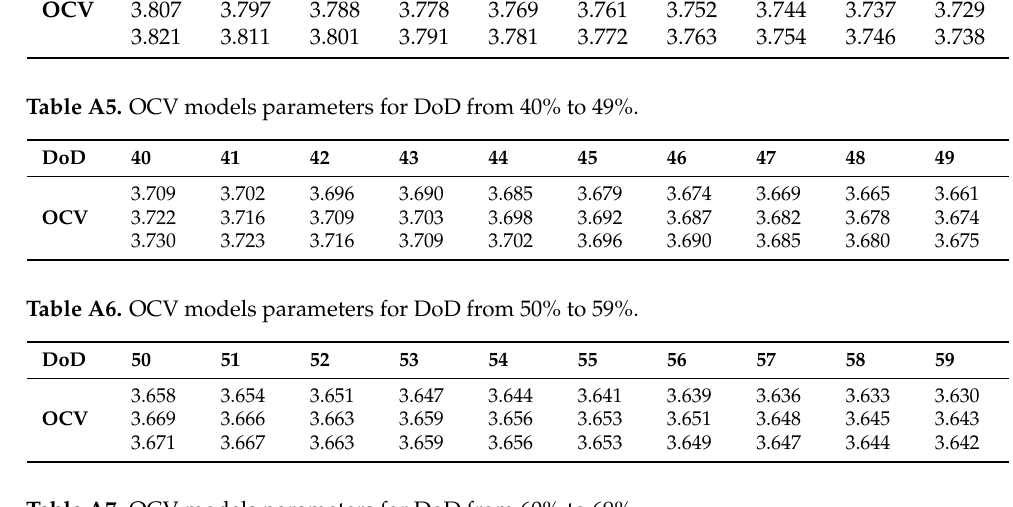
Table A7. OCV models parameters for DoD from 60% to 69%.